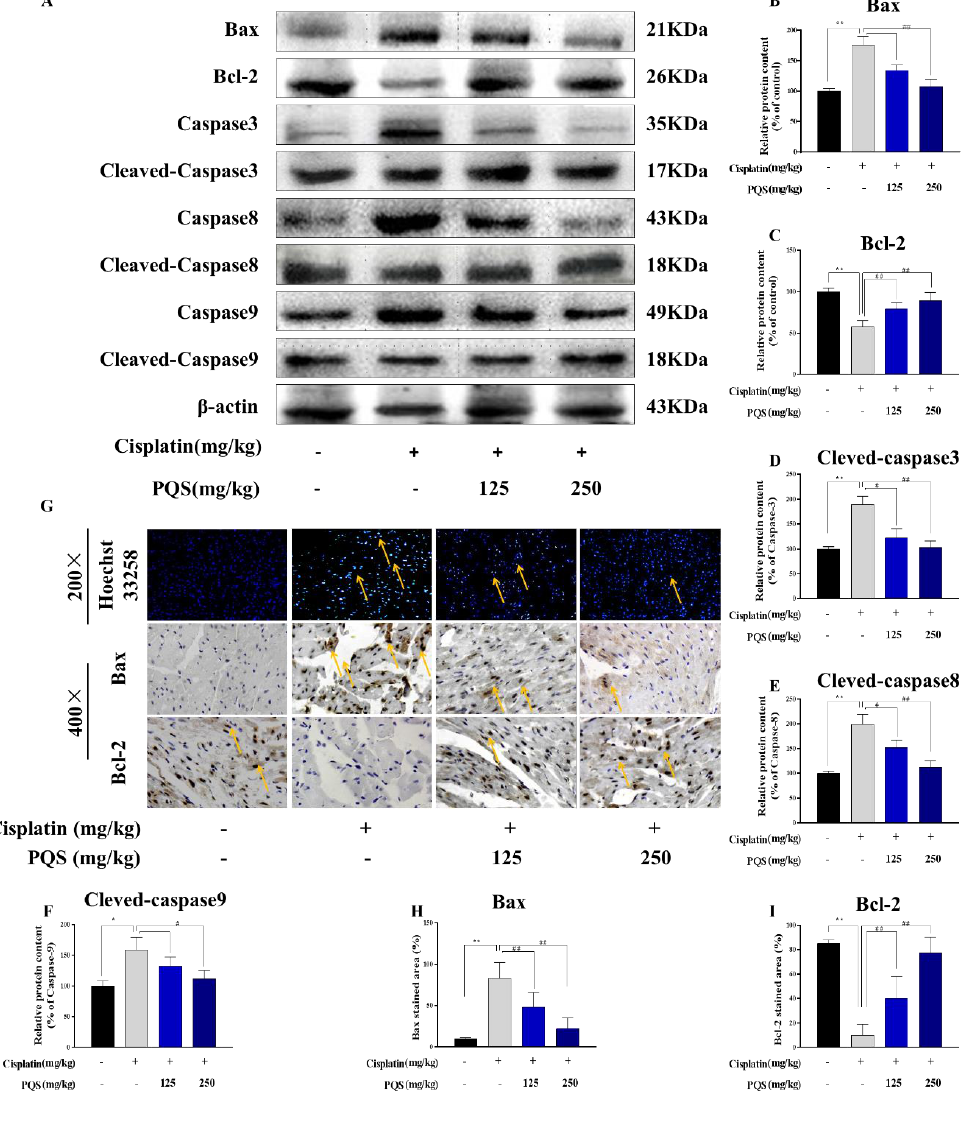
Figure 7. (A) The blots of Bax, Bcl-2, Bad, caspase 3, cleaved caspase 3, caspase 8, cleaved caspase